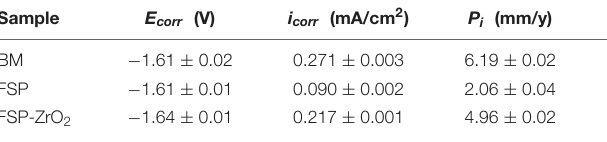
TABLE 2 | The results of E corr , i corr and P i of samples in SBF